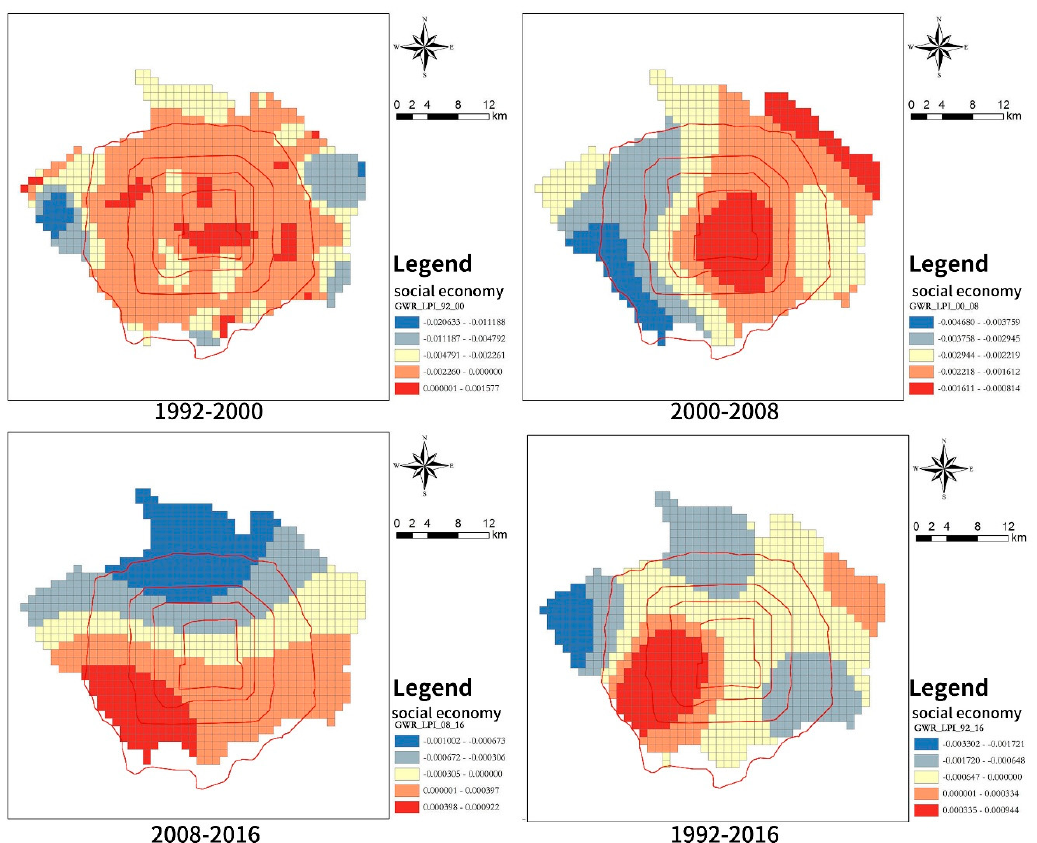
Figure 8. Spatial distribution map of coefficients between urbanization and largest patch index values of green space in central Beijing during the period 1992–2016.